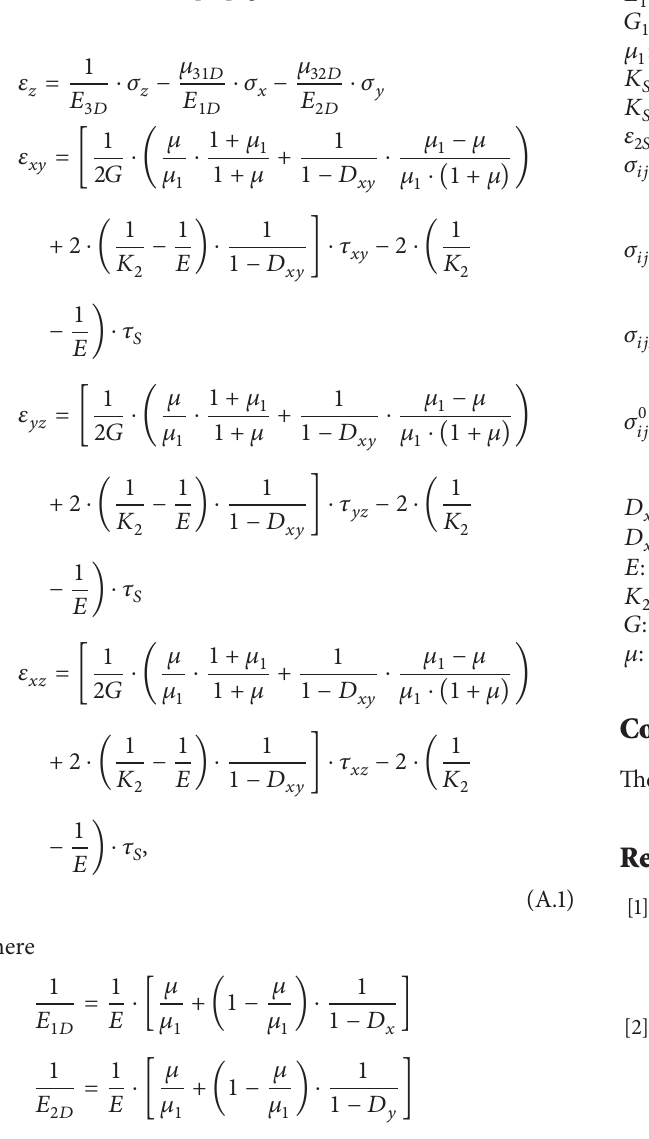
Figure 12: The crack propagation curve of satellite